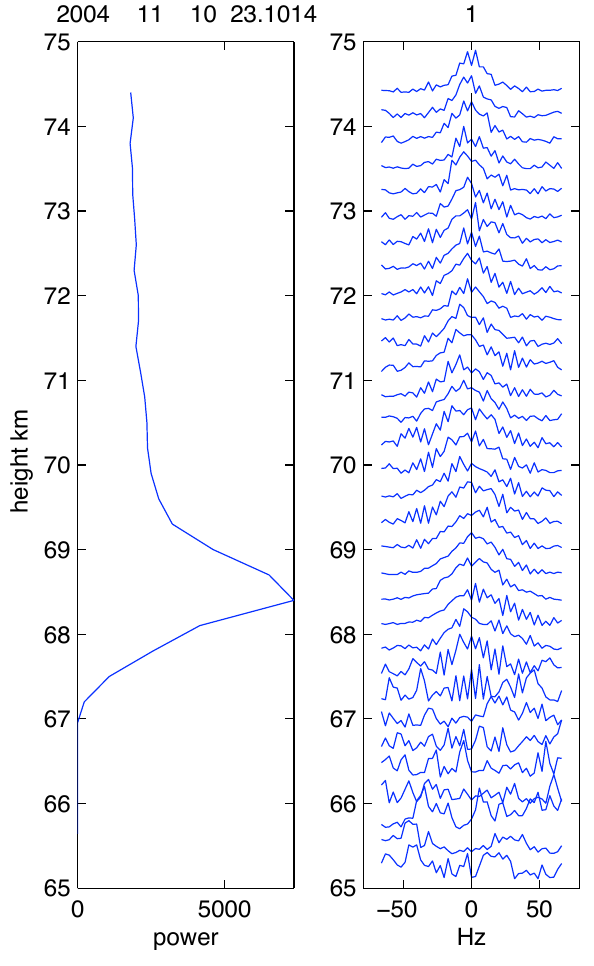
Fig. 6. EISCAT observations averaged 23:06–23:12 UT on 10 November 2004. Left-hand panel shows the height profile of echo power, right-hand panel shows echo spectra, normalised by the echo power.